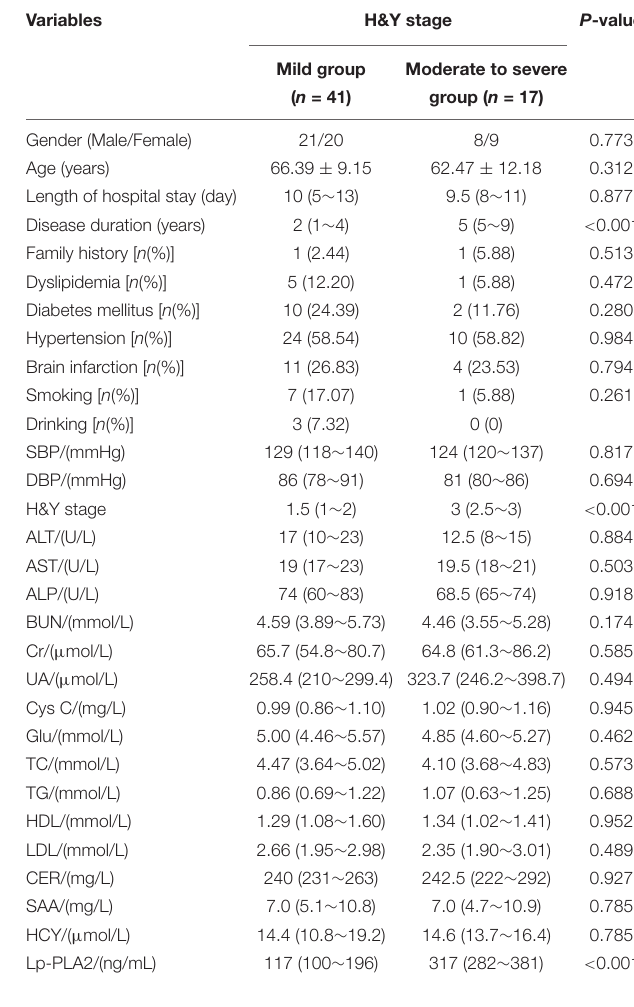
TABLE 3 | Comparison of laboratory findings between mild and moderate to severe outcomes of patients with